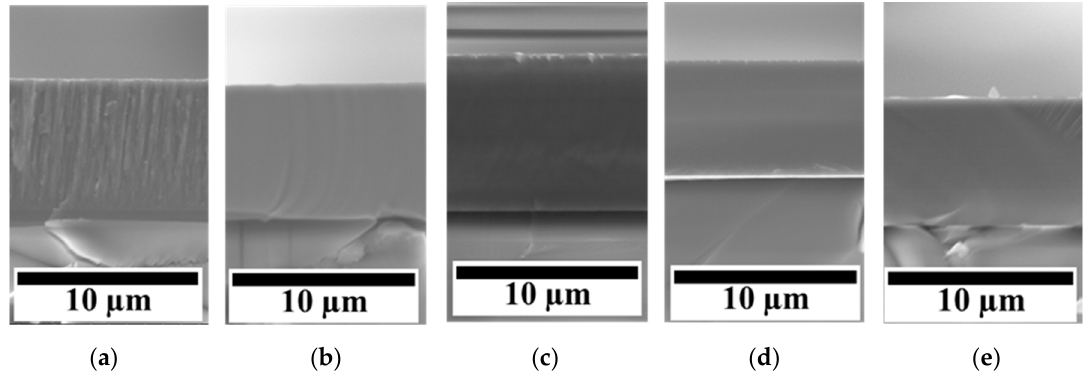
Figure 2. Cross-section scanning electron microscopy (SEM) images of as-deposited coatings 1 (Ar) ( a ), 2 (5 sccm N 2 ) ( b ), 3 (10 sccm N 2 ) ( c ), 4 (5 sccm C 2 H 4 ) ( d ), and 5 (10 sccm C 2 H 4 ) ( e ).